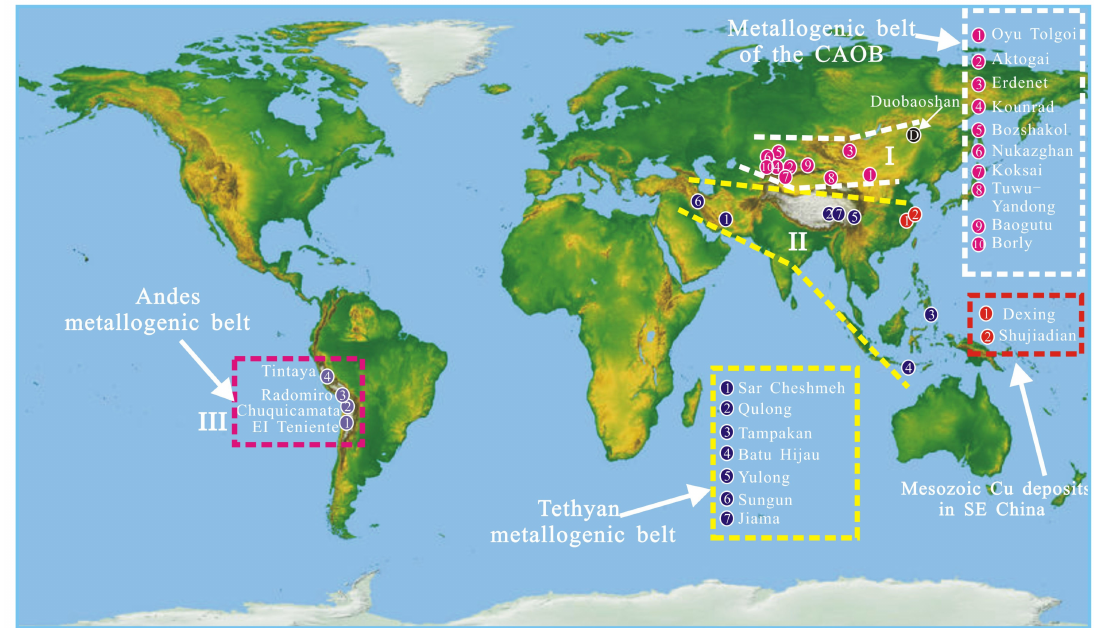
Figure 11. Distribution of the DBS-TS deposit and others in the well-known huge/large metallogenic belts of porphyry Cu-Mo-(Au) deposits across the world. Note area I = metallogenic belt of CAOB; area II = Tethyan metallogenic belt; and area III = central Andes metallogenic belt. Mesozoic Mo metallogenic belt in NE China is shown in Figure 2b, not shown